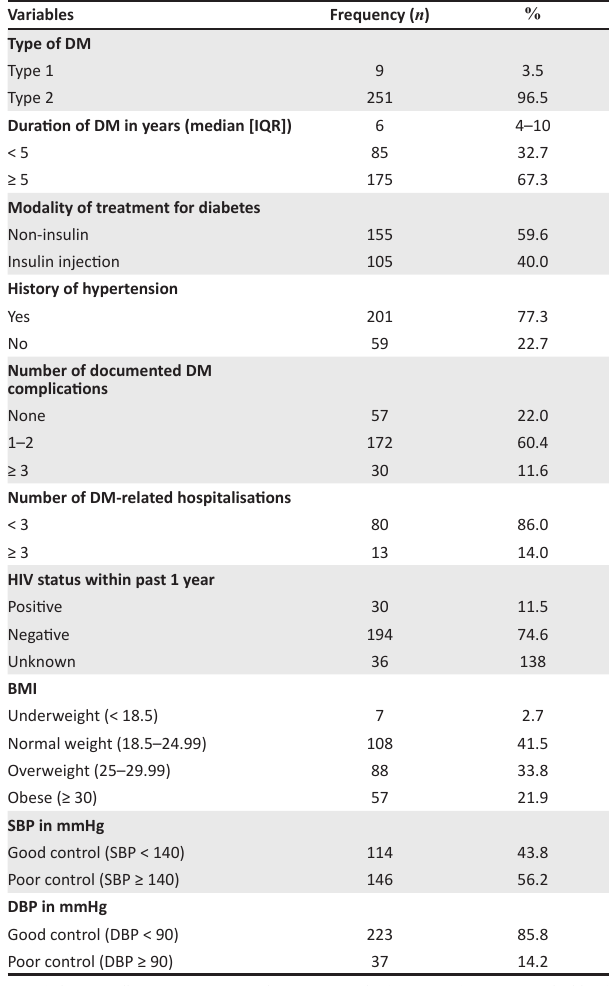
TABLE 2: Clinical characteristics of study participants.